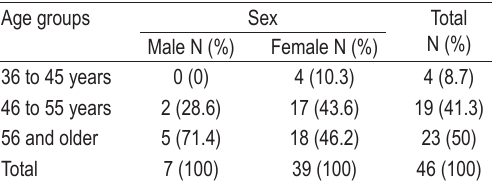
FIGURE 1. Length of service in a managerial position. TABLE 2. Assessment of the knowledge and attitude towards the provision of services in local community between the